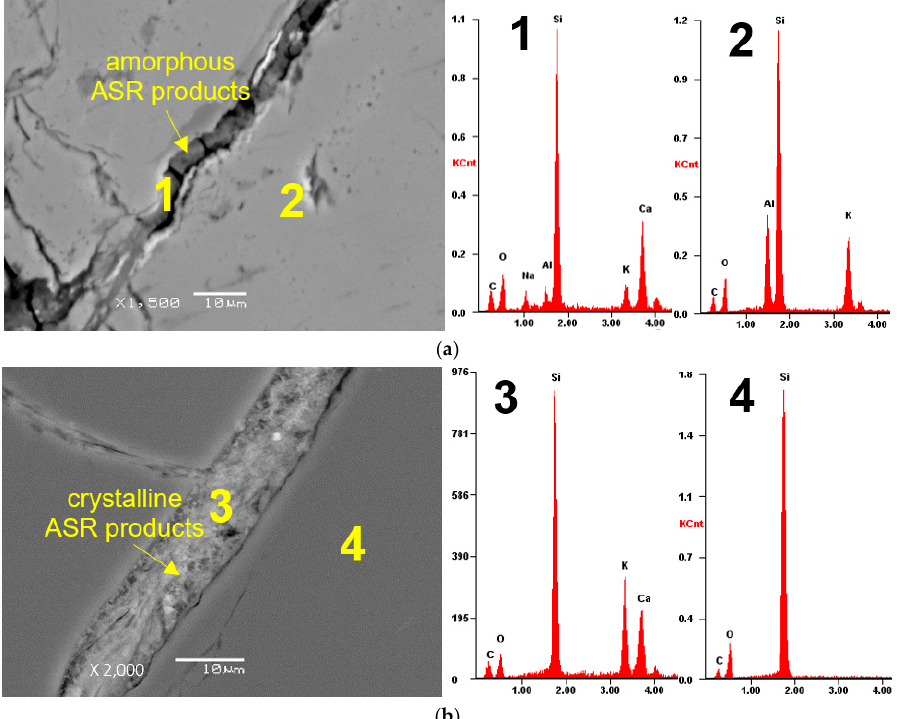
Figure 4. Microstructure of the mortar with aggregate G1 after 28 days of storage at 80 °C in ( a ) 1 M NaOH, crack in the aggregate grain filled with amorphous ASR products (1), potassium feldspar (2); ( b ) 50% HCOOK, crack in the aggregate grain filled with crystalline ASR products (3), quartz (4).